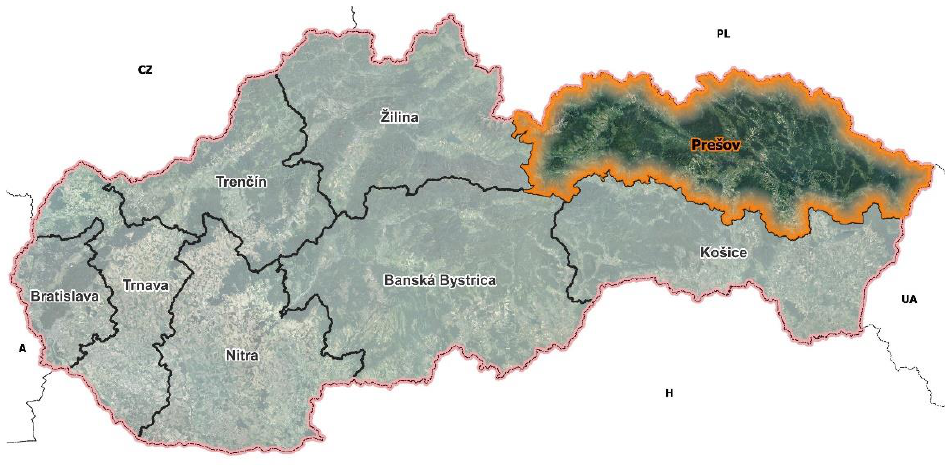
Figure 3. Prešov self-governing region marked in orange color (prepared by Dr. Štefan Koco).